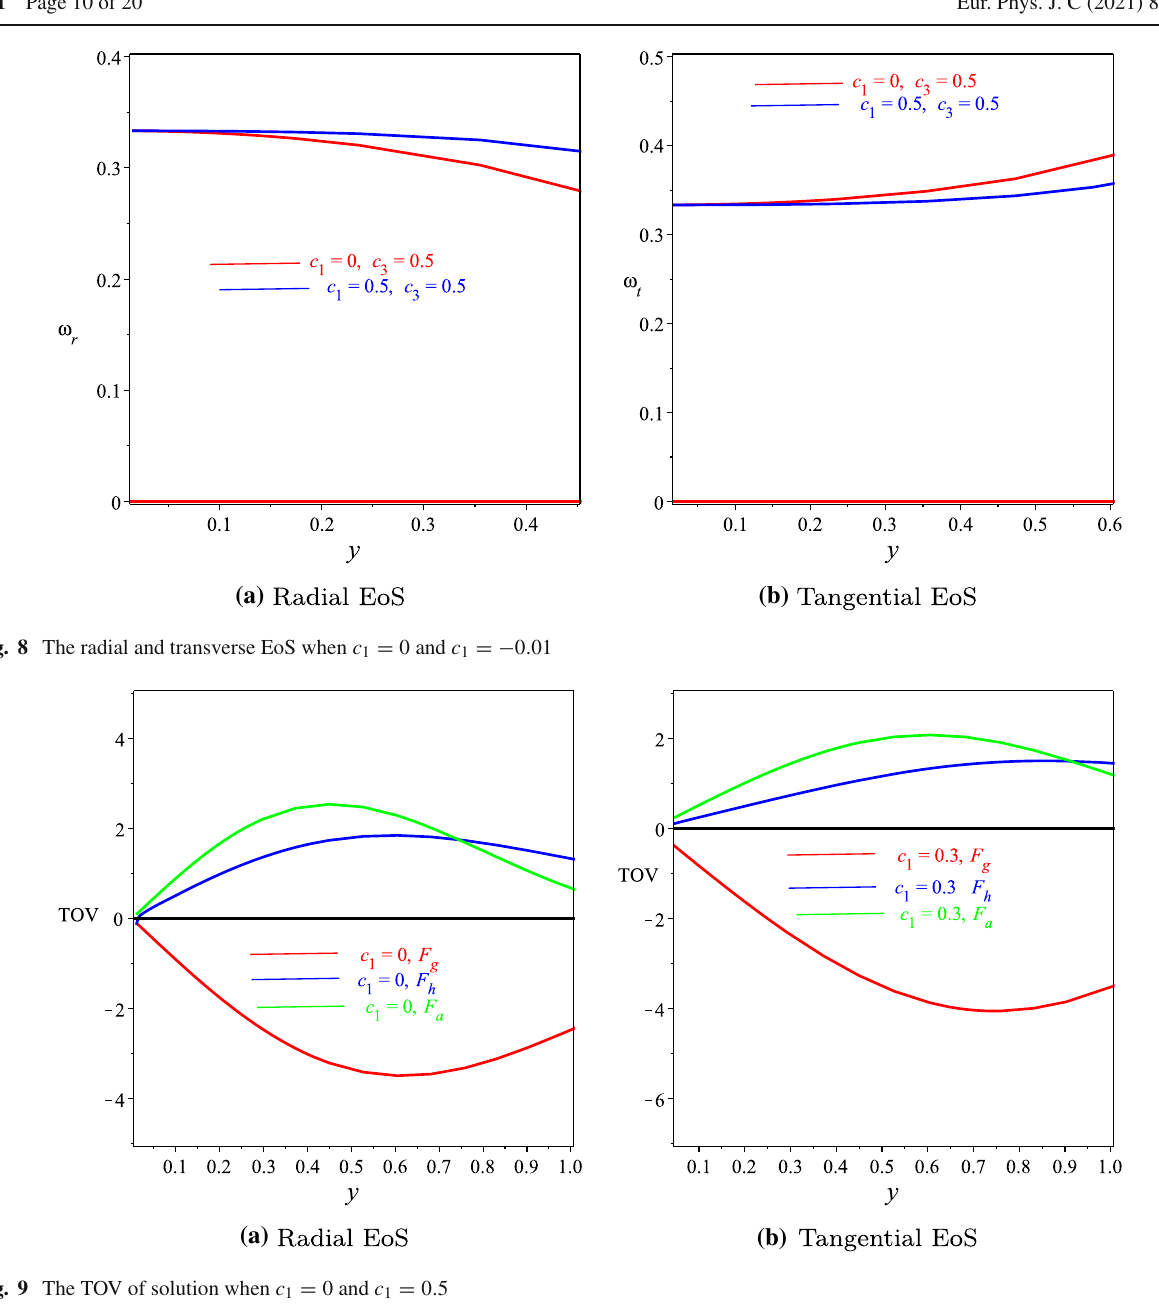
Fig. 9 The TOV of solution when c 1 = 0 and c 1 = 0 .